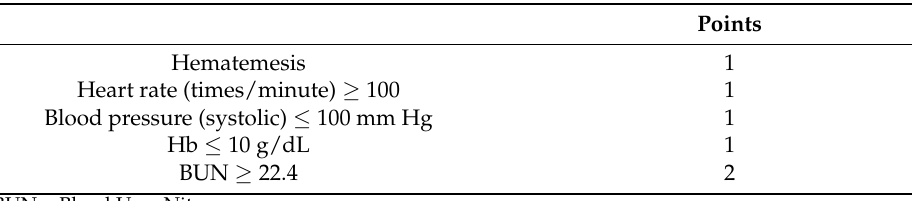
Table 7. H3B2 score [7].